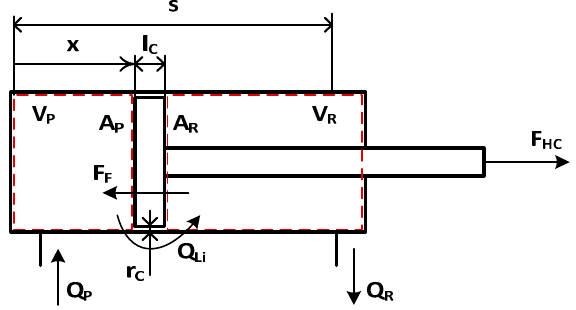
Figure 2. Control volumes considered for modelling the cylinder